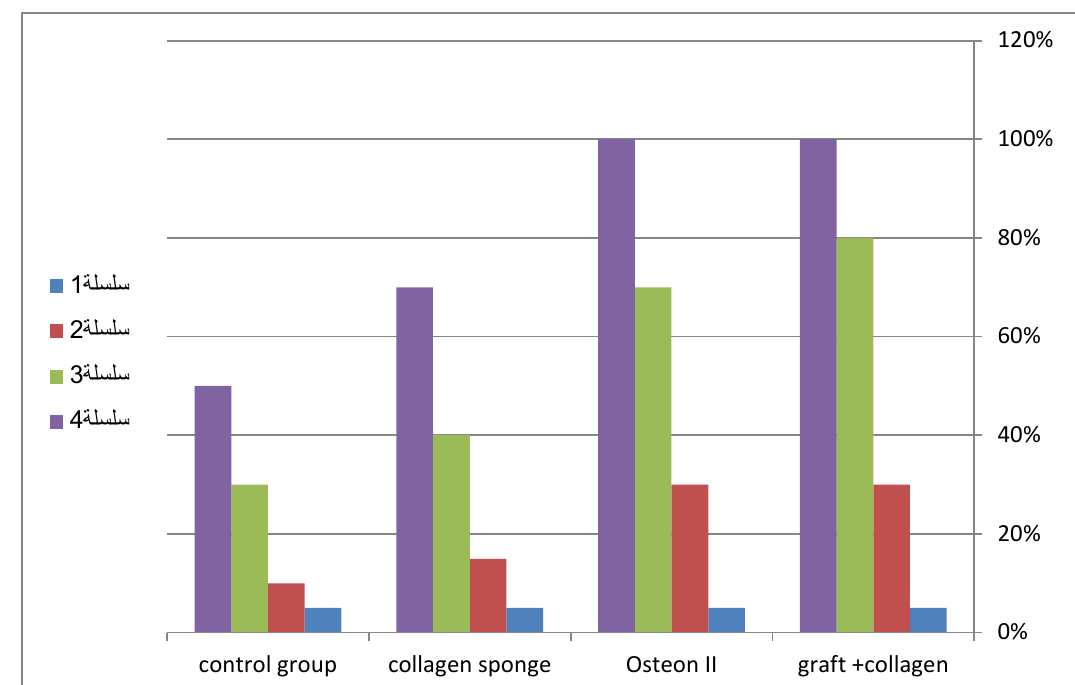
Figure (13): The healing % among the treated